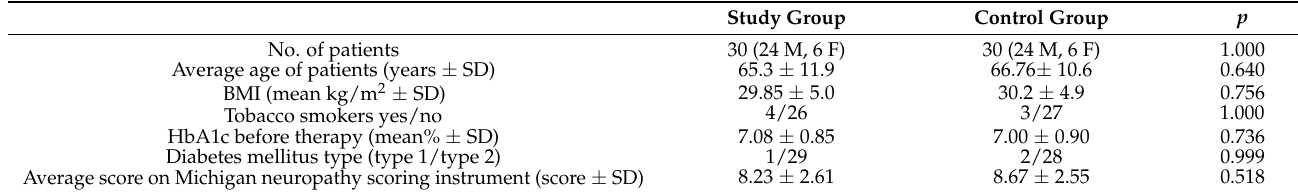
Table 1. Basic characteristics of the study and the control groups.